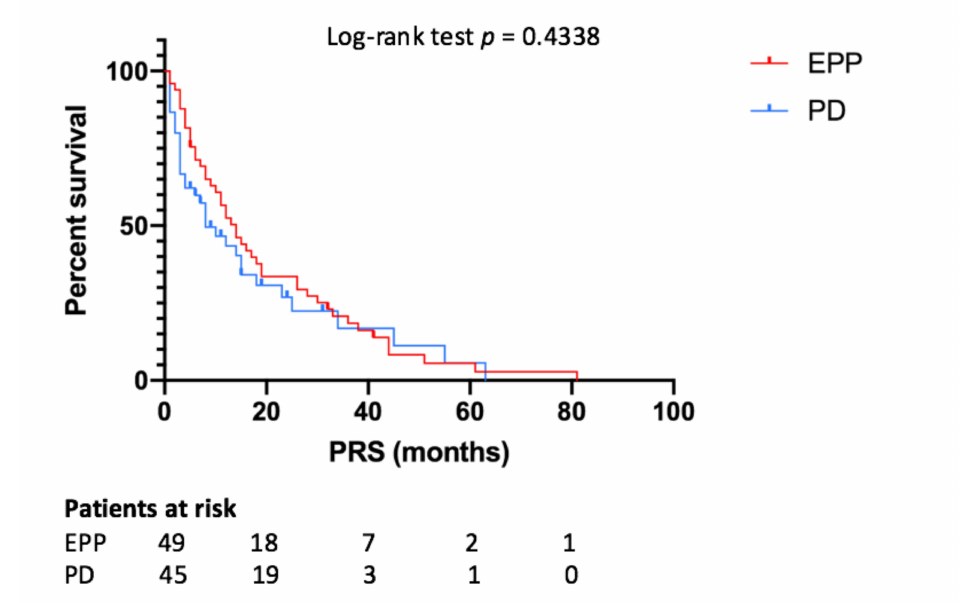
Figure 4. Post-recurrence survival depending on type of surgery. EPP—extrapleural pneumonectomy; PD—pleurectomy/ decortication; PRS—post-recurrence